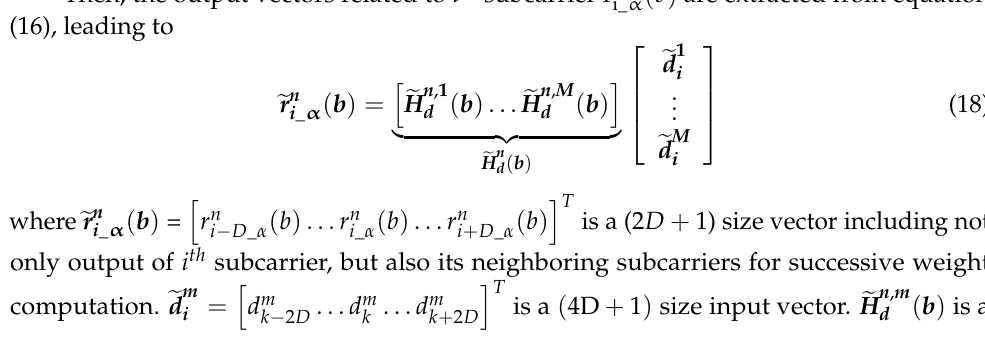
( b ) are extracted from equation i_ α